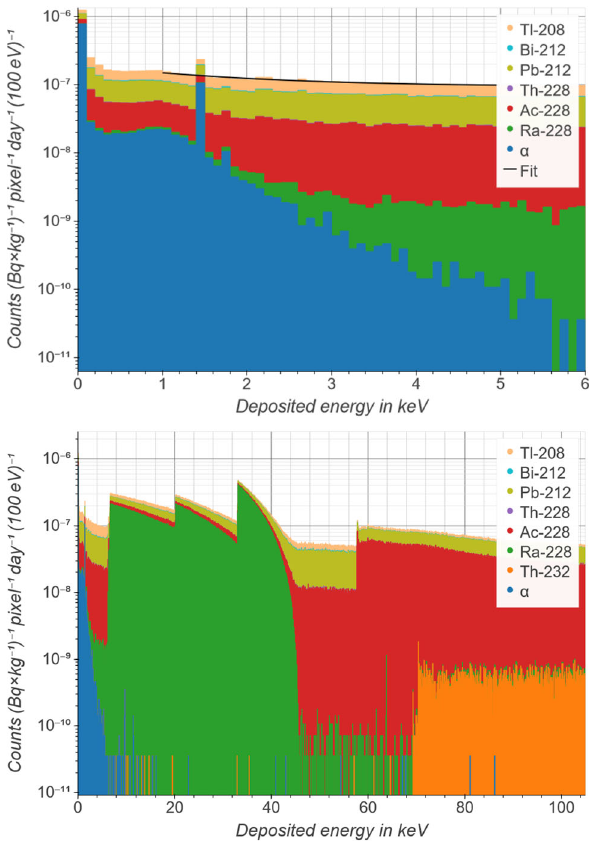
Fig. 7 Simulated spectrum of deposited energies in the MMC absorbers caused by the bulk-distributed 40 K in the absorbers. The β - spectrum is flat for low energies and the Ar shell levels due to the EC/ β + -decay can be seen about ( 4 . 5 ± 0 . 1 ) · 10 − 10 day − 1 pixel − 1 is expected in the